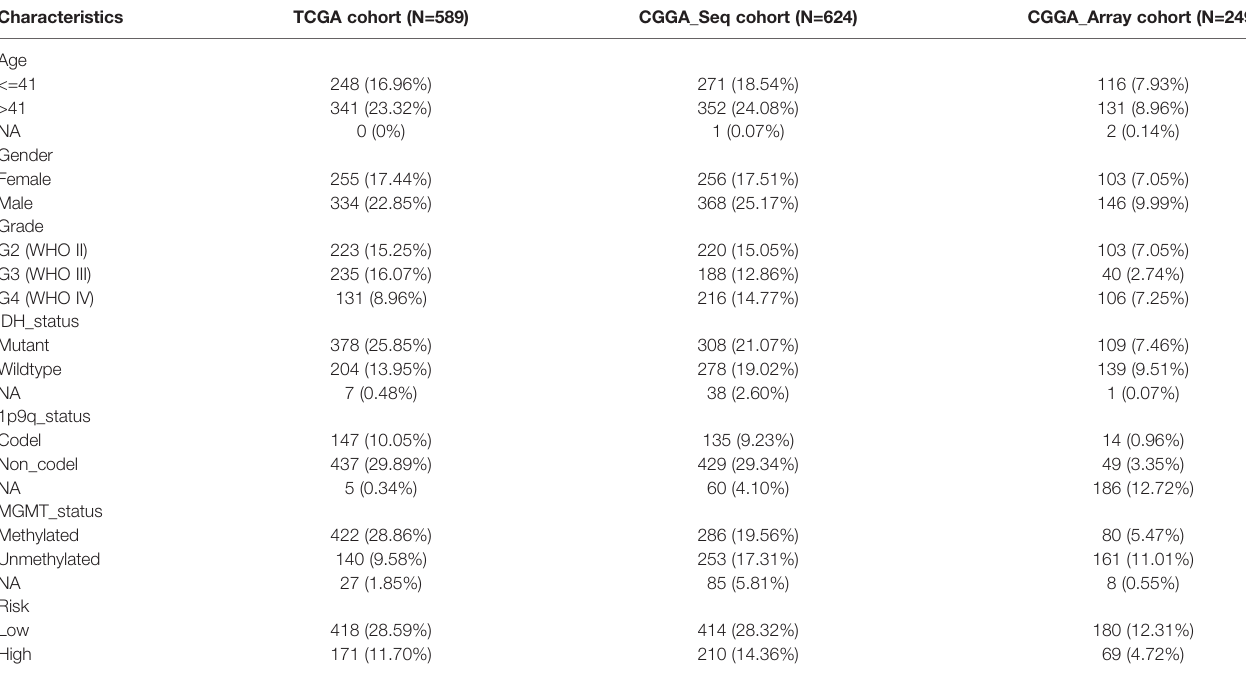
TABLE 1 | The clinical characters of different